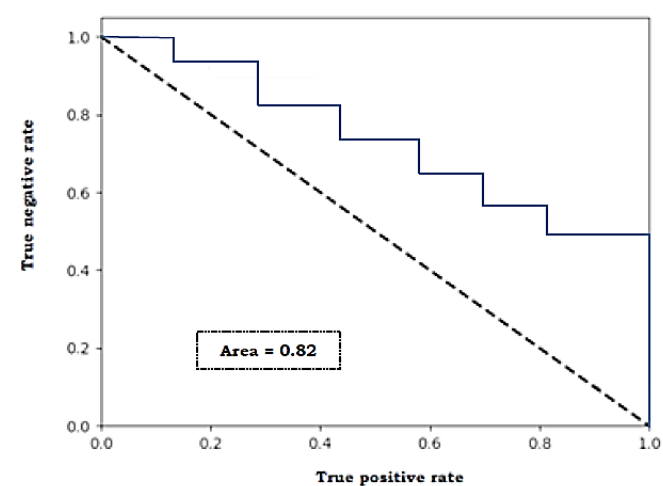
Figure 7. Receiver operating characteristic curve for random forest.